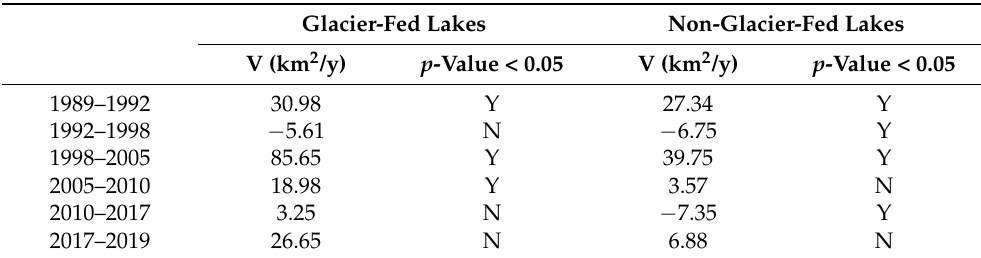
Table 2. Change rates and corresponding p -values in six intervals of the studied period for glacier-fed and non-glacier-fed lakes. Glacier-Fed Lakes Non-Glacier-Fed Lakes V (km 2 /y) V (km 2